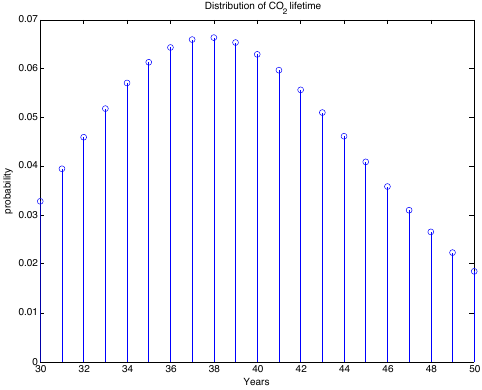
Figure 10. Estimated probability distribution ξ .